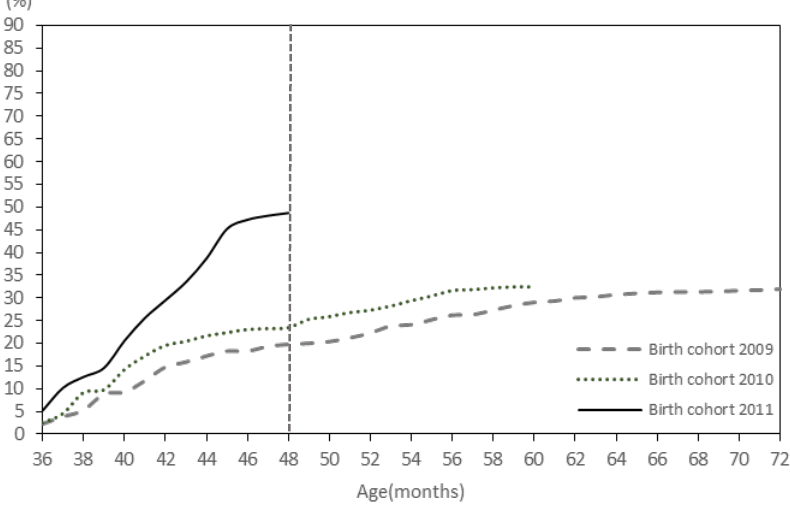
Figure 2. The coverage rate of VarV 2 for children aged 4–6 years.